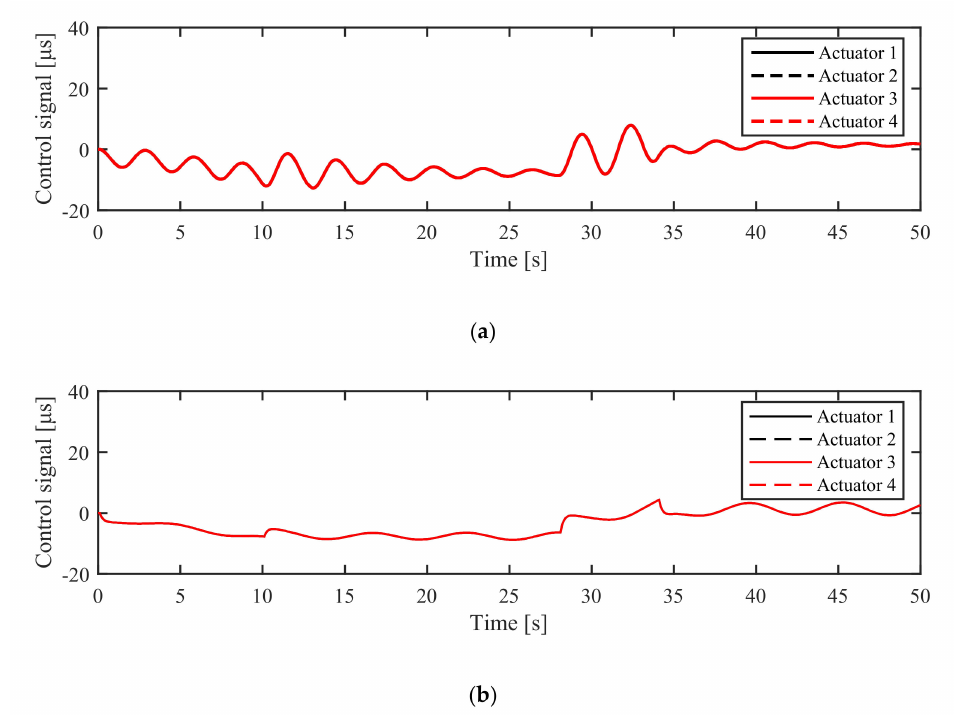
Figure 8. The control signal: ( a ) Proposed controller; ( b )